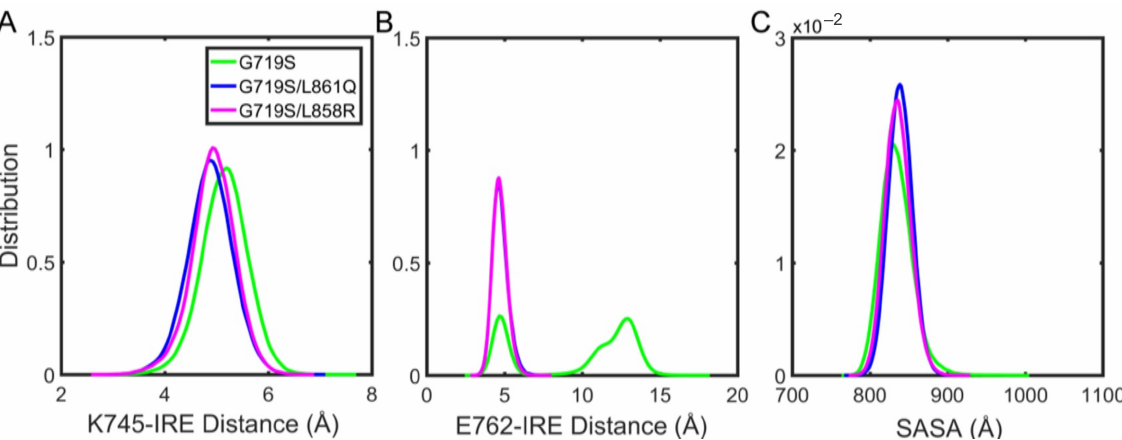
Figure 8. The probability distribution profiles of ( A ) the distance between atoms K745/NZ and IRE/F, ( B ) the distance between atoms E762/(OE1, OE2) and IRE/F, and ( C ) the solvent-accessible surface area (SASA) for the binding region of IRE